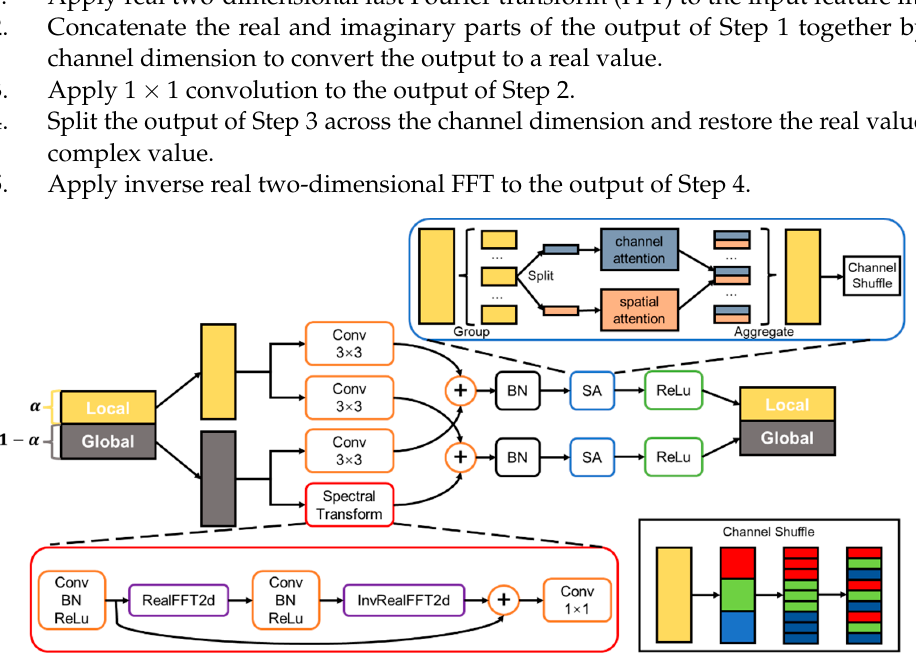
Figure 6. An overview of the proposed SA-FFC module.